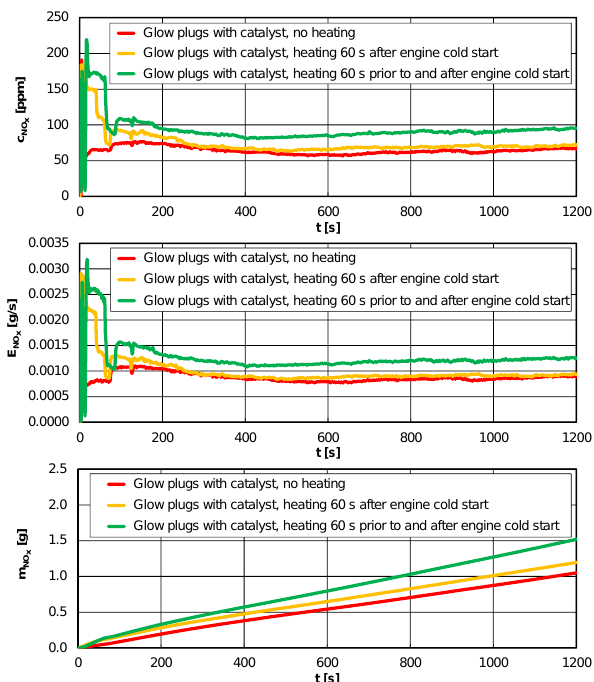
Fig. 4. Concentration, intensity of emission and emission of nitrogen oxides during the tests performed on a diesel engine depending on the catalyst-coated glow plug heating time In the case of particle number, the test results are not varied. All tracings of the particle number intensity are similar in their nature and values and only the final values of the particle number allow a correct assessment of the environmental benefits. The particle number in the entire measurement period for different glow plug heating cases fell in the range 3–3.5·10 11 (Fig. 5).